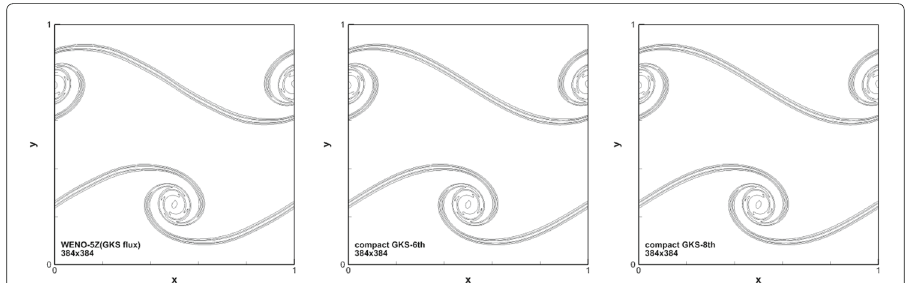
Fig. 23 Double shear flow: vorticity contours at t = 0.8, obtained by non-compact nonlinear reconstruction-based WENO-5th(GKS flux), the 6th-order and 8th-order compact GKS with 384 × 384 mesh